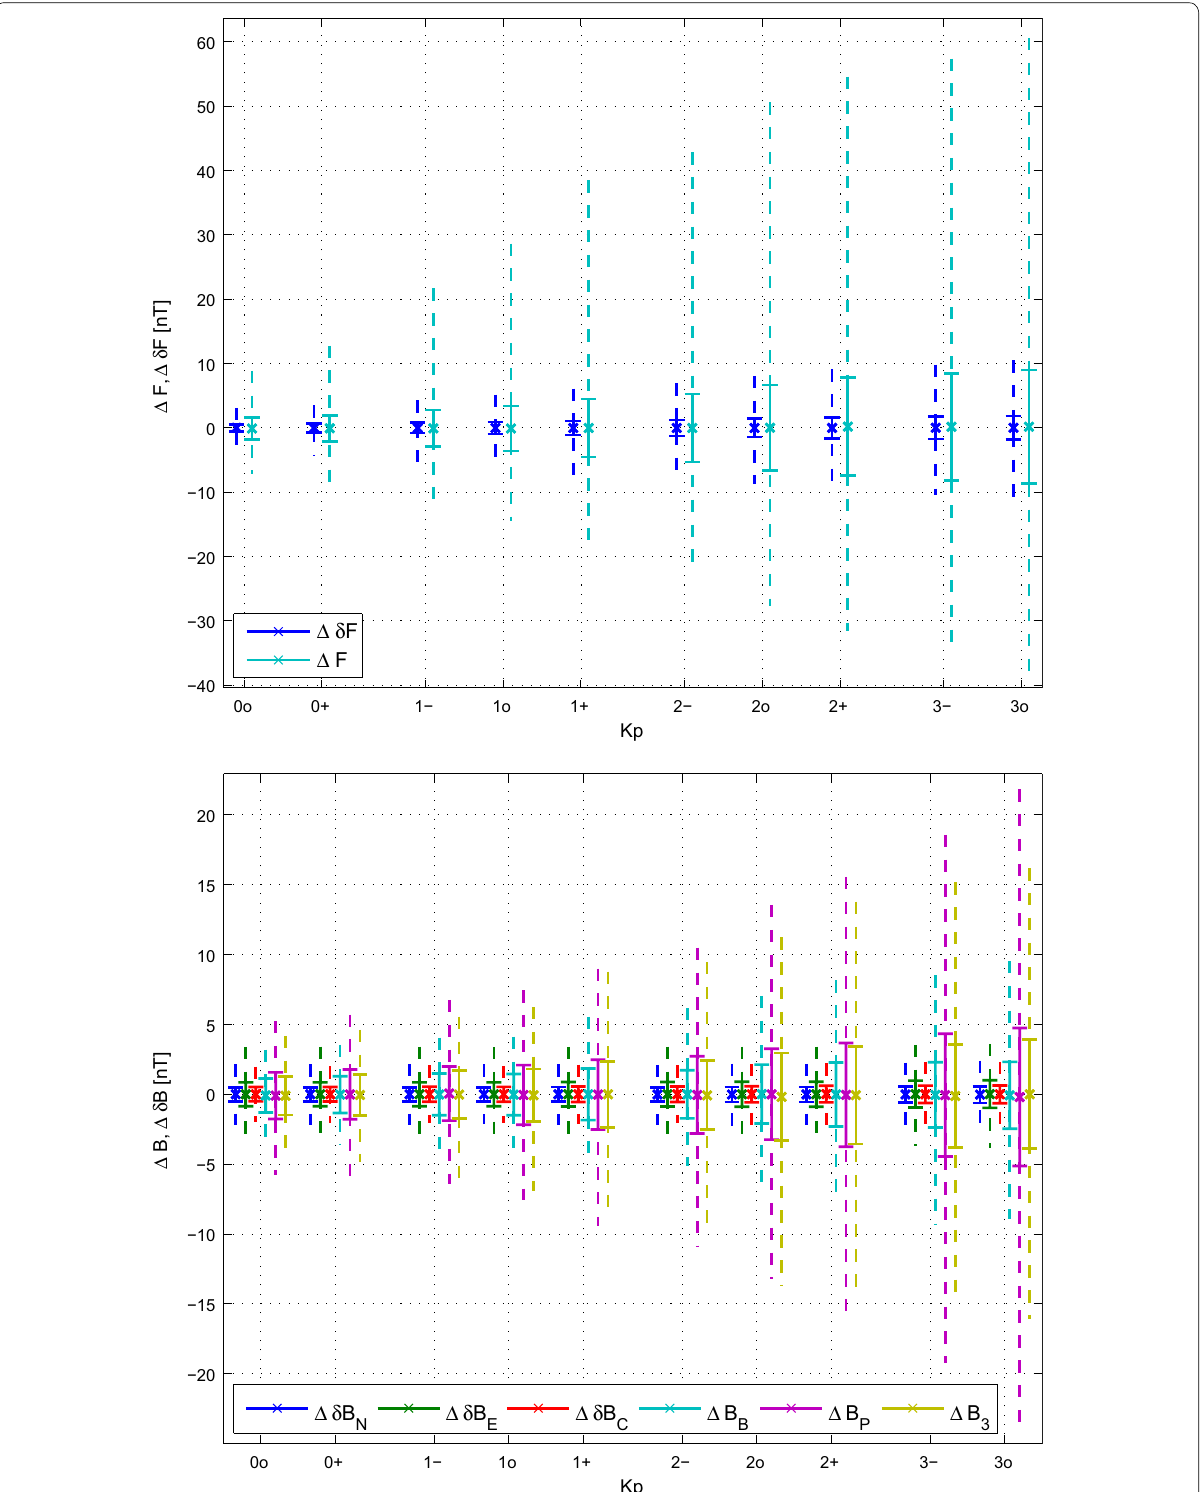
Fig. 2 Residuals of the scalar field (cid:31) F and differences �δ F (top) and the vector field (cid:31) B and differences �δ B (bottom) from CIY4 for Swarm Alpha with respect to Kp activity level. The “X” denote the weighted means while the bars indicate weighted standard deviations. The dashed lines indicate ± 99% of the residual ranges. Note that the vector components for the field data are BP3 , but are NEC for the difference